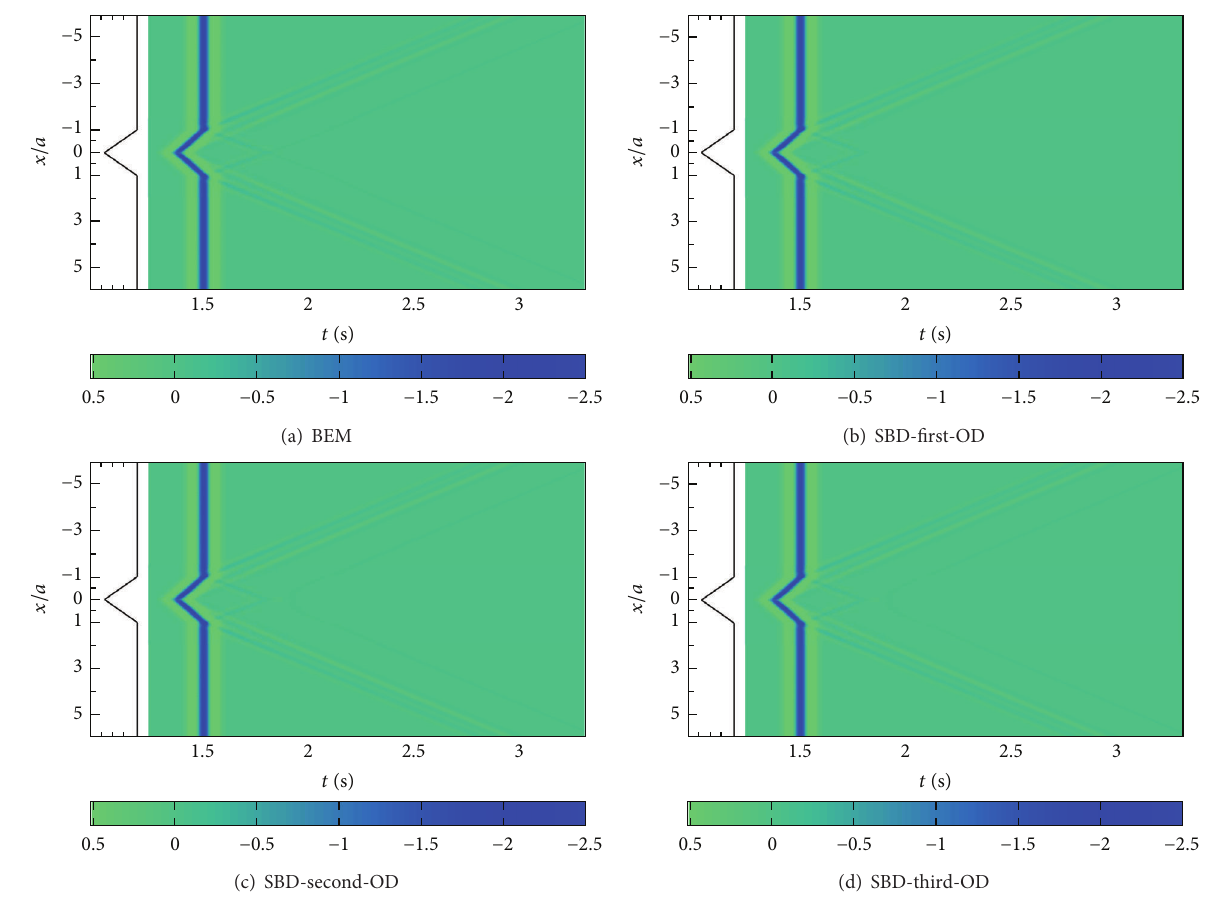
Figure 13: Synthetic seismograms for receivers over the canyon surface obtained with the BEM algorithm and the current SBD approach.